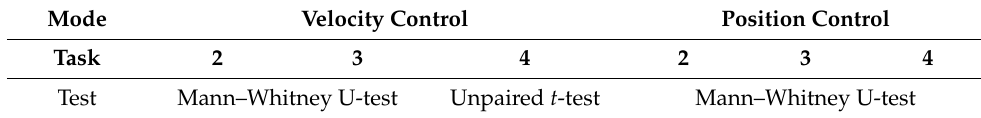
Table A7. Tests to compare the performance of the